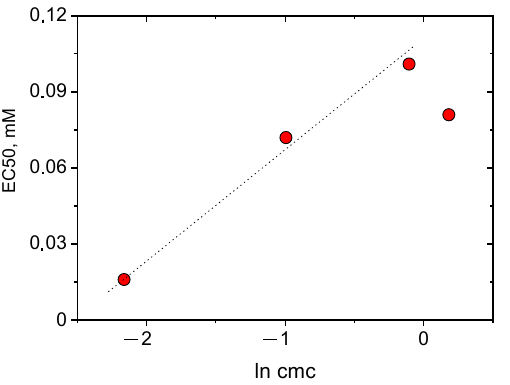
Figure 4. 50% effective concentrations EC50 for SARS-CoV-2 inactivation as a function of critical micelle concentration cmc of different cationic surfactants in semi-logarithmic representation.